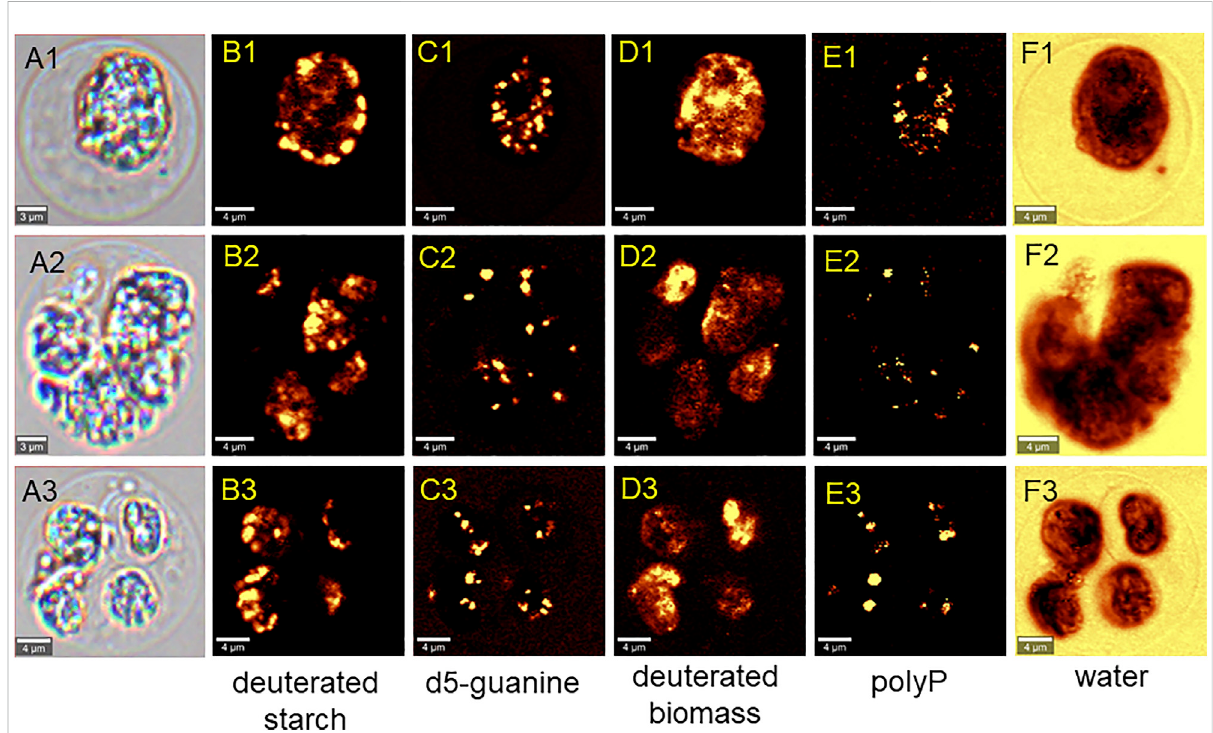
FIGURE 11 Raman chemical maps of three representative C. reinhardtii cells cultivated in the 90% D 2 O for 4 days. In the cells, spatial distribution of deuterated starch (B1 – B3), crystalline deuterated d5-guanine (C1 – C3), deuterated general biomass (D1 – D3), polyphosphates (E1 – E3) and water (F1 – F3) is shown.